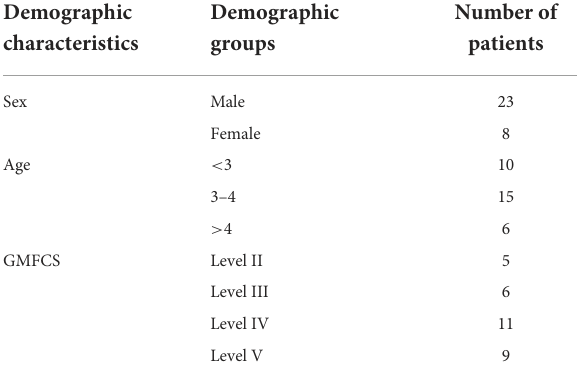
TABLE 1 Clinical features of the studied cohort (total number =